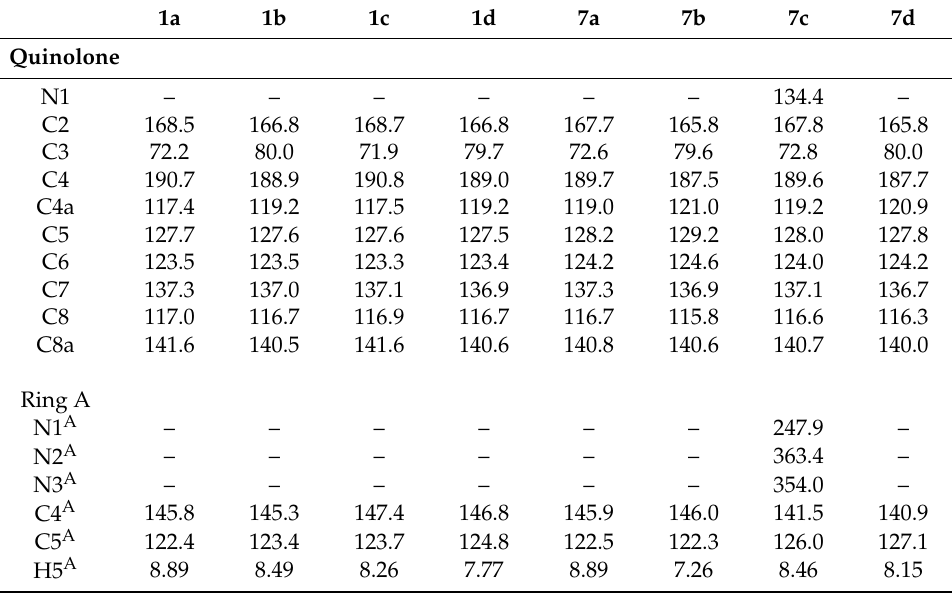
Table 5. Selected 1 H, 13 C and 15 N NMR chemical shifts in ppm for compounds 1 and 7